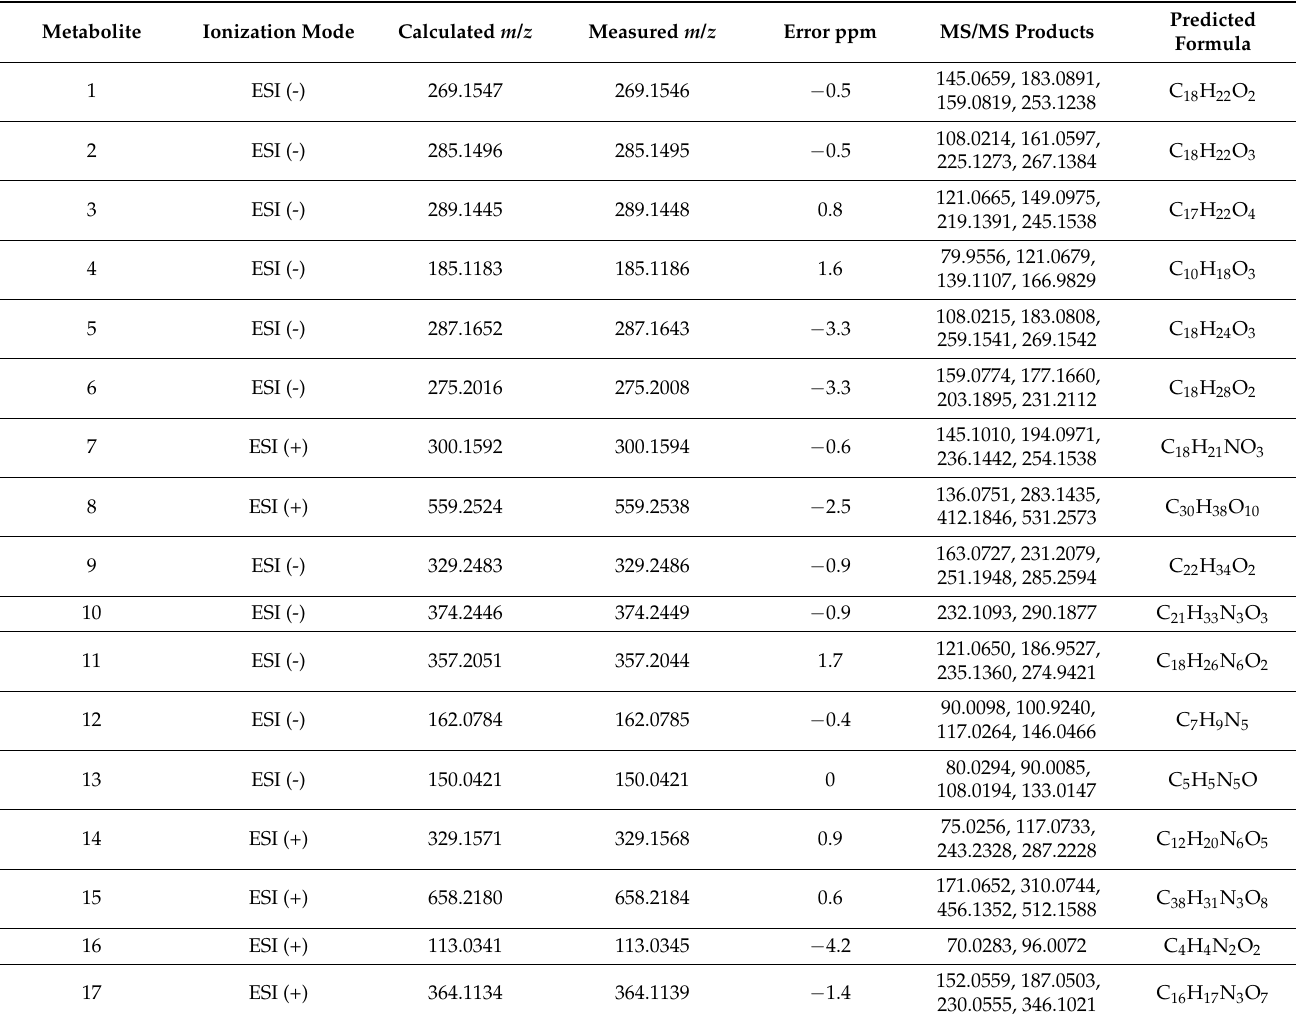
Table 1. E2 metabolites detected by UPLC/ESI-QTOF-MS